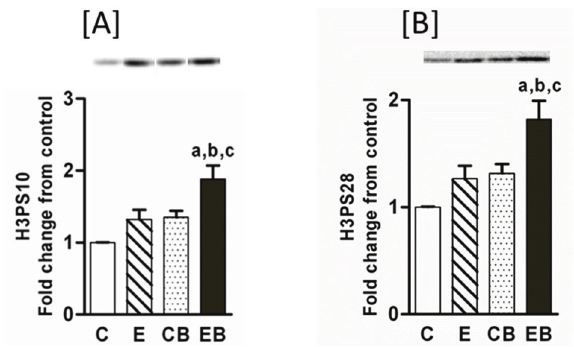
Figure 3. Phosphorylated histone H3S10 and S28 in chronic and chronic ethanol binge